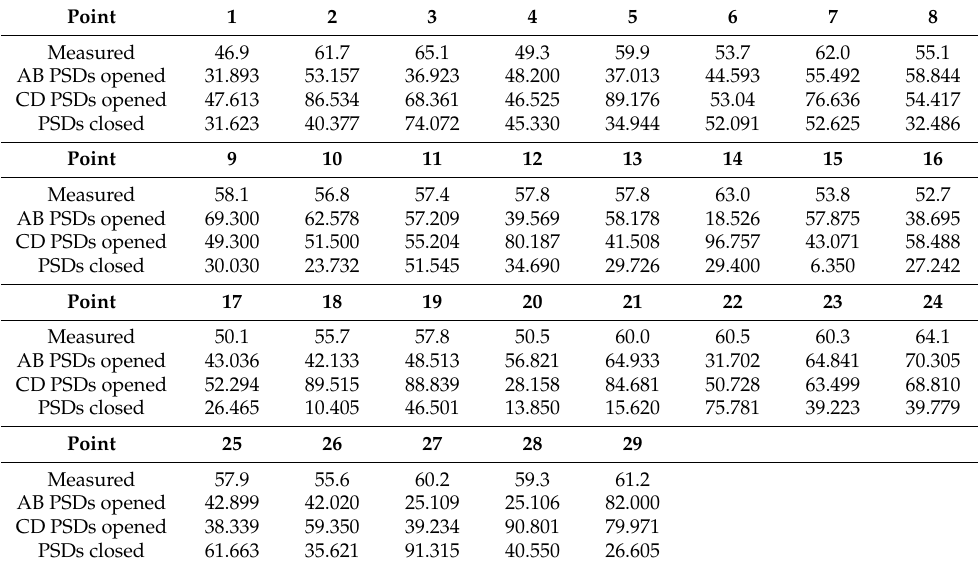
Table A2. Measured and simulated PM2.5 concentrations at sampling points of the platform